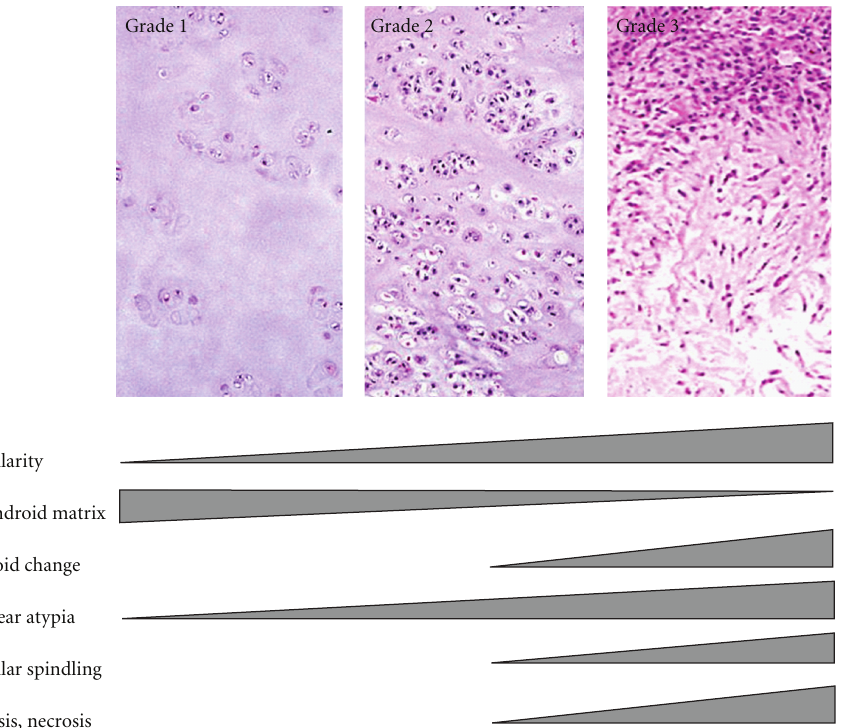
Figure 5: Schematic representation illustrating grading system of conventional CHS (not all CHSs follow this